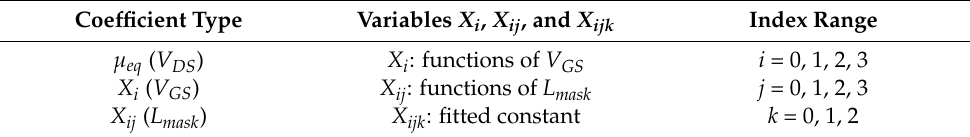
Figure 4. μ eq vs. V DS characteristics under different V GS at L mask = 500 nm in section X = a . Table 2. The relationship between each parameter and the coefficient in Taylor’s